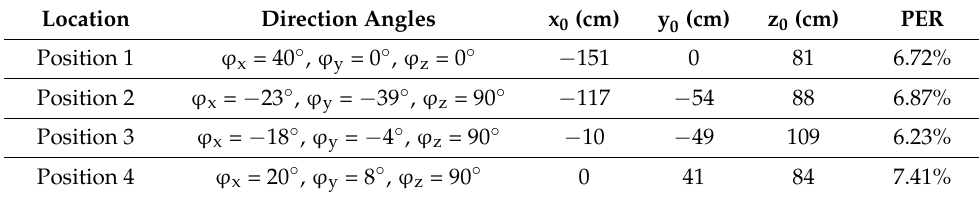
Table 4. Measured direction angle, coordinates, and positioning error of